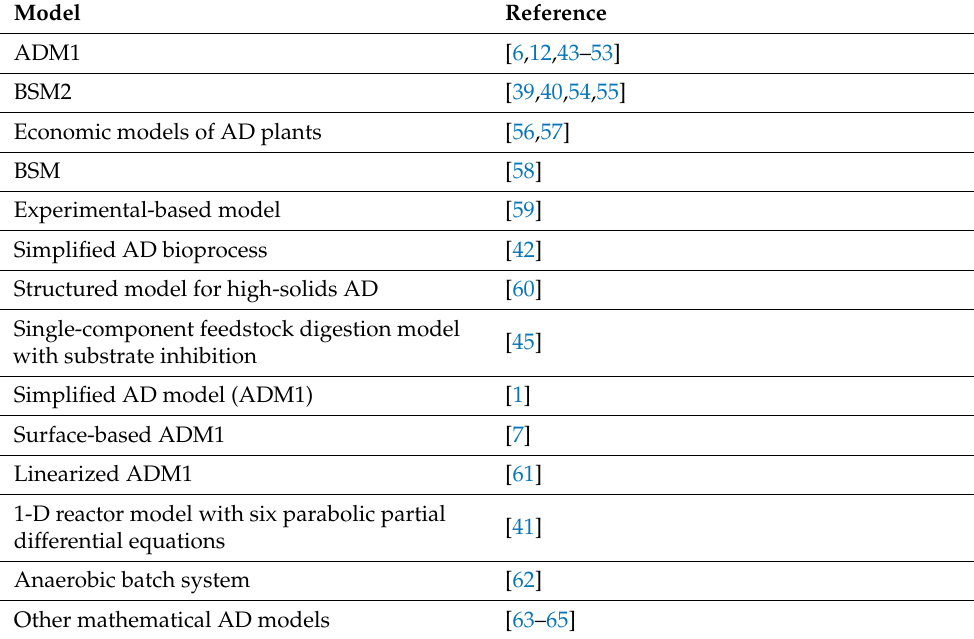
Table 1. Models used in sensitivity analyses .